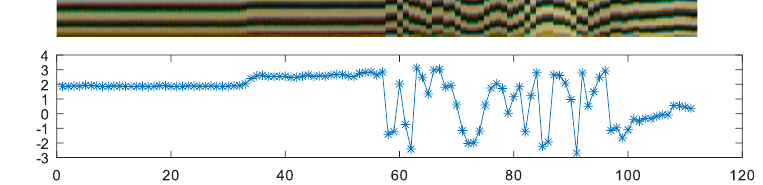
Figure 8. Phase data analysis.